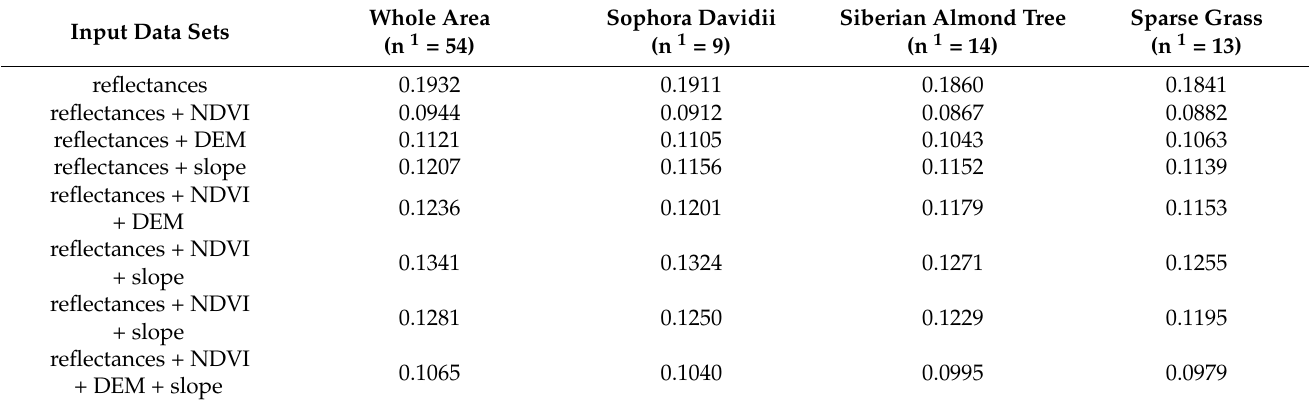
Table 2. RMSEs of the downscaled SM derived from 1 km SPL2SMAP_S SM product (m 3 /m 3